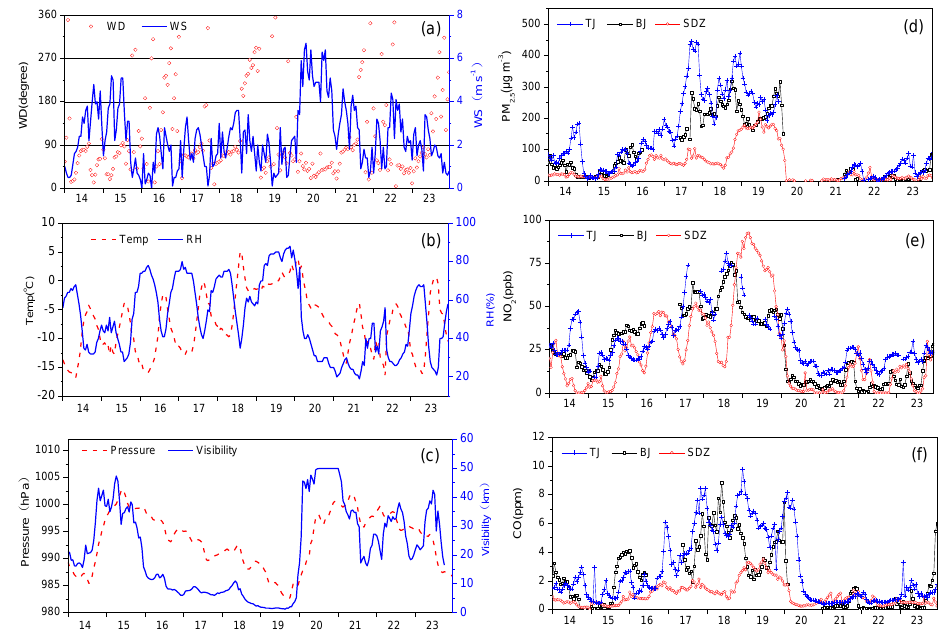
Fig. 3. Time series variations of meteorological parameters at SDZ and pollutants at TJ, BJ and SDZ from 14 to 23 January 2010. (a) wind direction and wind speed (ms − 1 ) , (b) temperature (°C) and relative humidity (%), (c) atmospheric pressure (hPa) and visibility (km), (d) PM 2 . 5 concentration (µgm − 3 ) , (e) NO 2 (ppb), (f) CO(ppb)